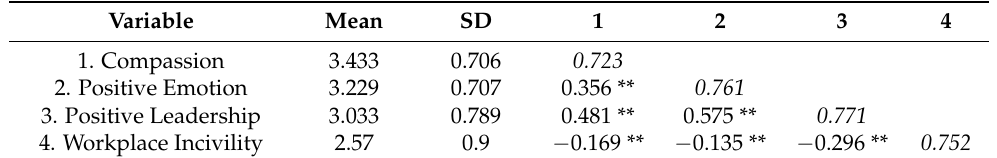
Table 1. Descriptive